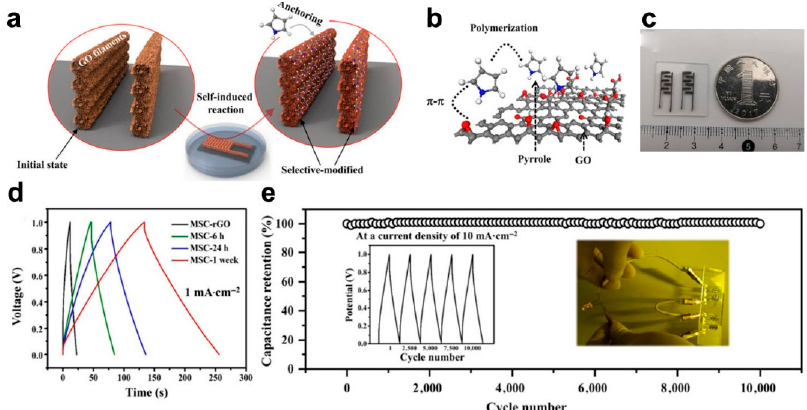
Figure 4. In situ modified rGO with polymer. ( a ) Schematic illustration for growth pyrrole on the surface of rGO micro-patterned electrode; ( b ) The interaction between rGO and pyrrole; ( c ) Photo- graph of the printed rGo/Ppy based MSC; ( d ) GCD profiles of the MSC; ( e ) Cycling stability of the MSC. The figure has been reproduced with permission from Springer Nature [58].